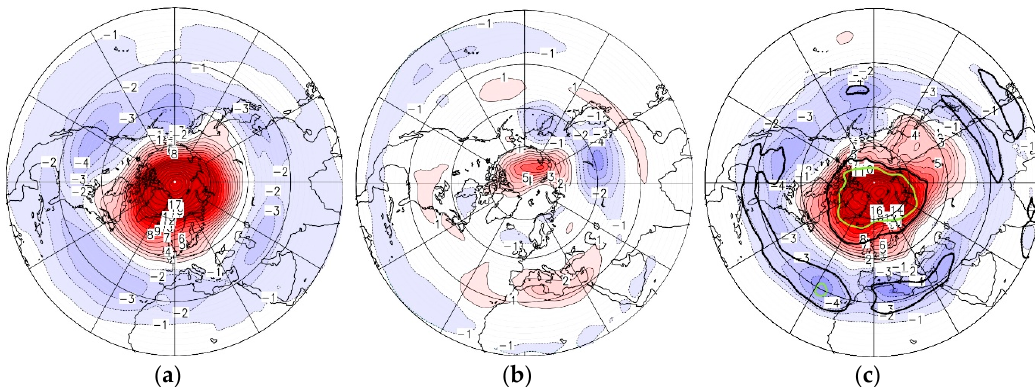
Figure 6. Stereographic maps of mean total ozone (TO3) anomaly (10 − 4 kg/m 2 ) for strong ‐ PJO events ( a ), non ‐ PJO events ( b ), and difference of strong ‐ PJO minus non ‐ PJO events ( c ) for ERA ‐ Interim averaged over 15 days after CD. Thick black (green) line in ( c ) includes significant areas with differences of 80% (95%) confidence. Total ozone means column integrated ozone.